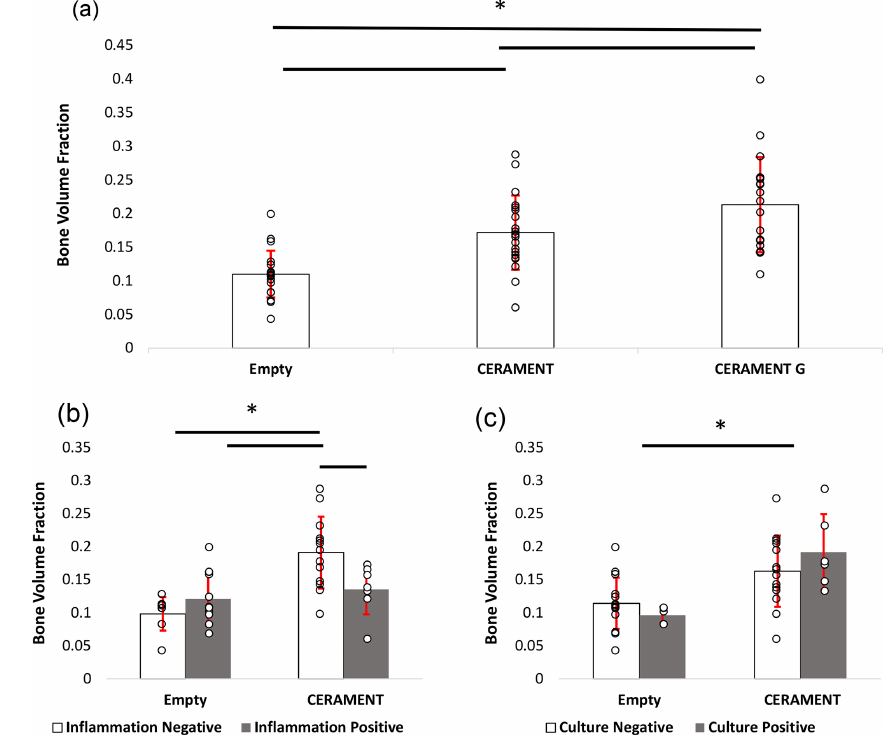
Figure 6. Measurement of new bone growth in empty, CERAMENT, and CERAMENT G groups ( n = 20): CERAMENT G increased new bone growth compared to empty and CERAMENT groups (a) . Animals in the CERAMENT group with histologically evident osteomyelitis formed significantly less bone than those that did not have osteomyelitis (b) . Animals which were culture-positive or culture-negative formed a similar level of bone in both empty and CERAMENT groups. * p < 0 . 05 using ANOVA + Student–Newman–Keuls post hoc method. Error bars represent ± 1standard